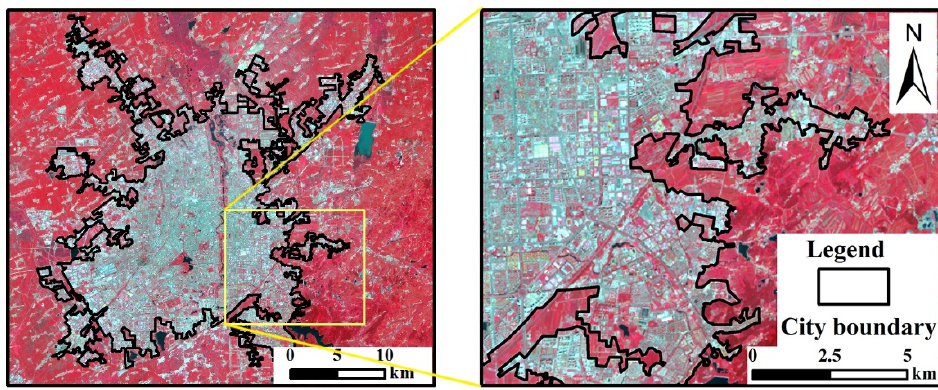
Figure 2. The identification of urban area in this study.